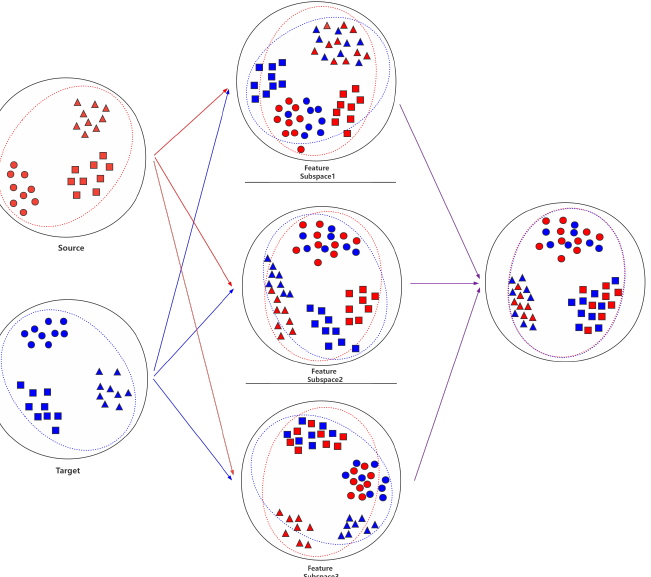
Figure 6. Feature alignment method of MRAN.